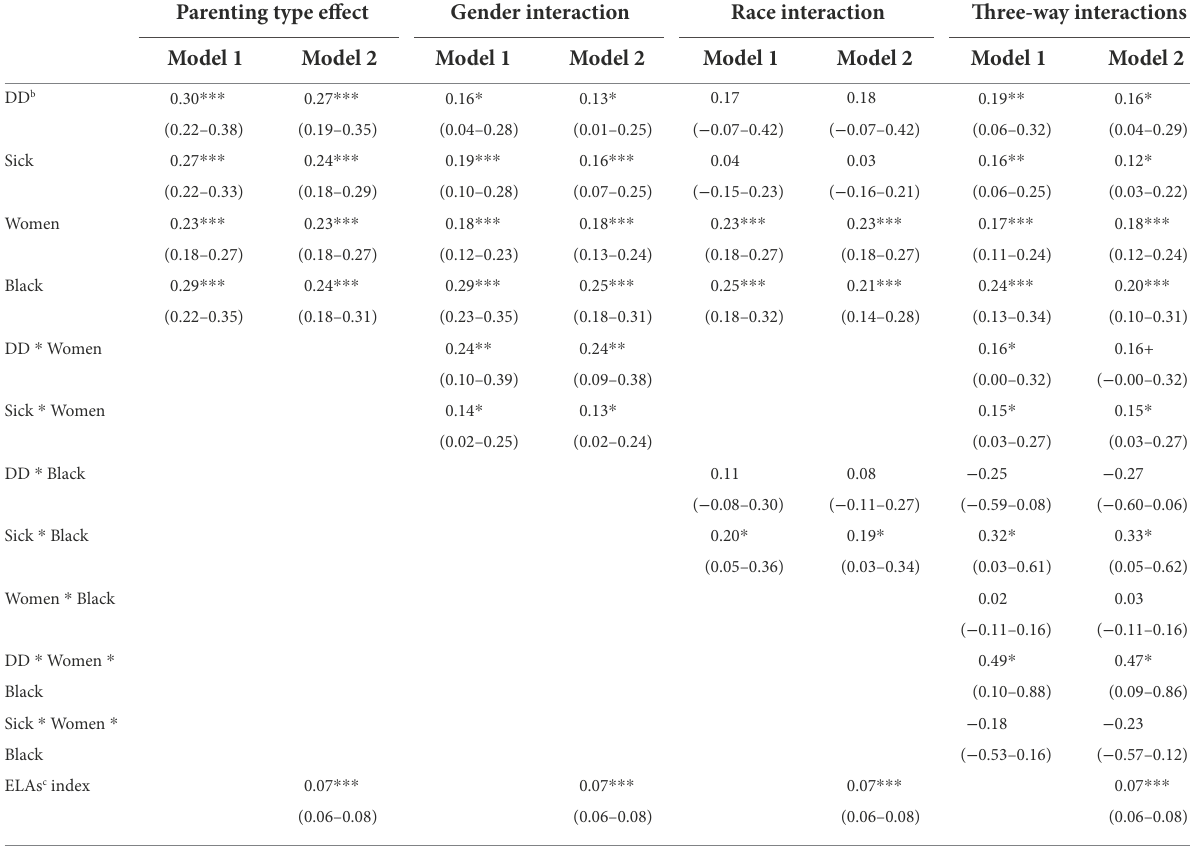
TABLE 3 Estimates of the effects of parenting type and interactions on chronic illness (n = 7,425) a